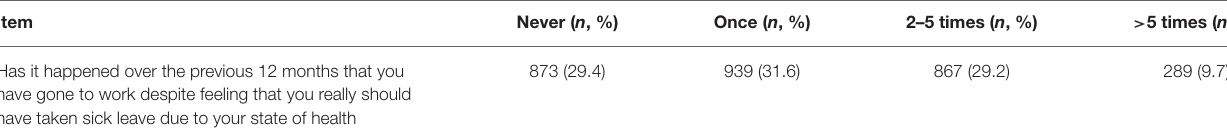
TABLE 1 | Descriptive statistics of the nurses’ sickness presenteeism ( N =